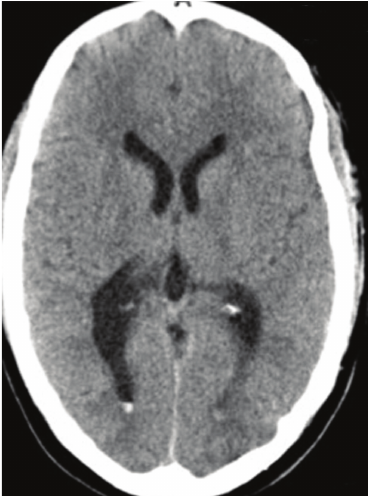
Figure 2: Noncontrast axial computed tomography scan of the head done 3 days after epidural blood patch showing a small amount of blood layering the occipital horns of both lateral